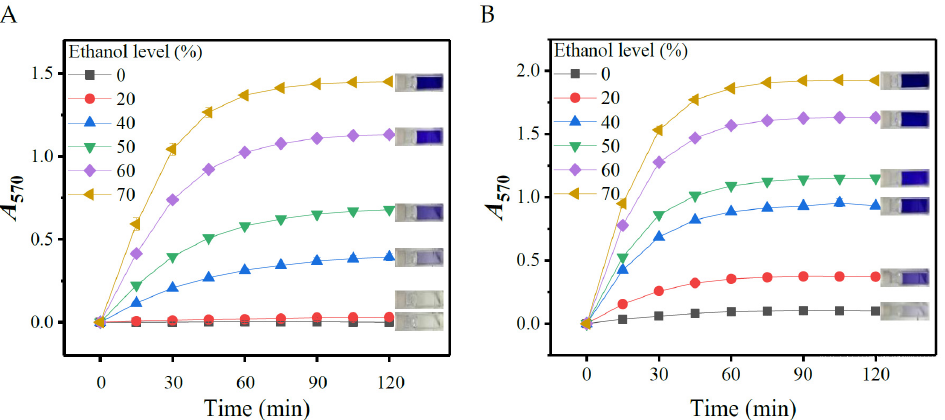
Figure 1. Effects of ethanol level on color yield of gamma-aminobutyric acid ( A ) and L-glutamic acid ( B ). The rightmost part of each diagram shows the reacted mixtures containing different levels (from top to bottom: 70, 60, 50, 40, 20, and 0%) of ethanol. A 570 : absorbance at 570 nm.